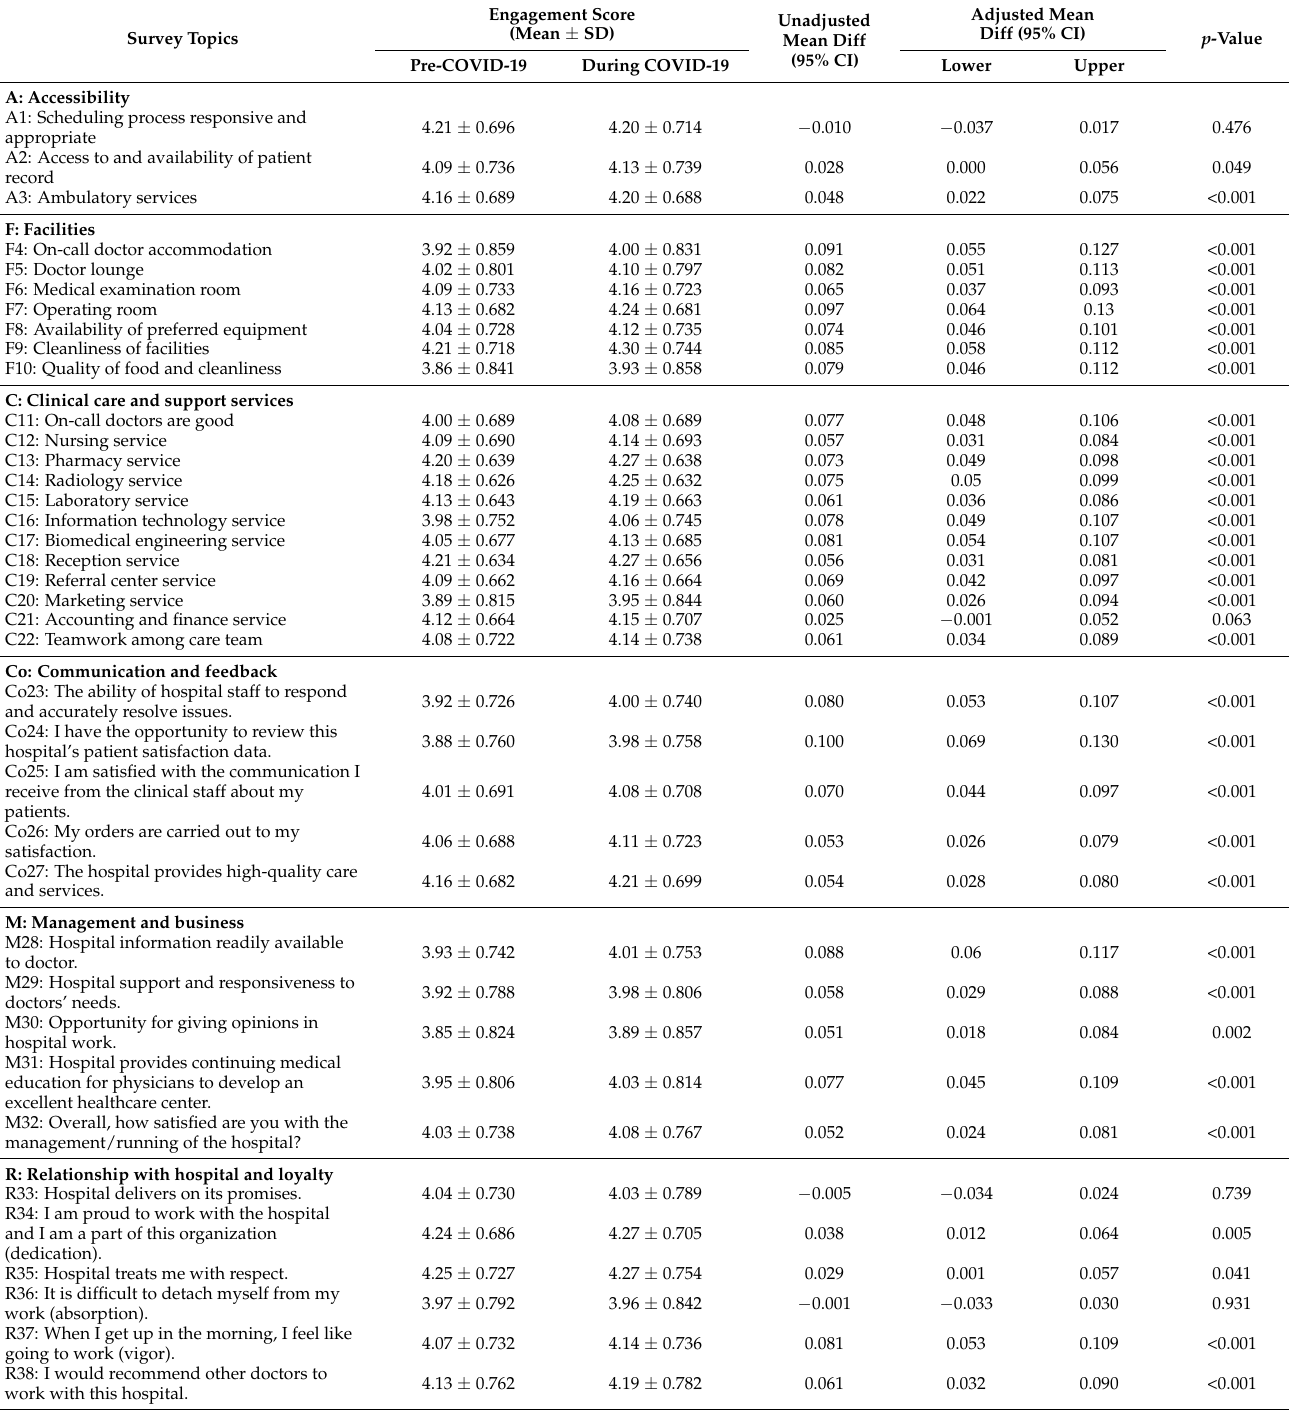
Table 4. Physician engagement scores categorized by survey